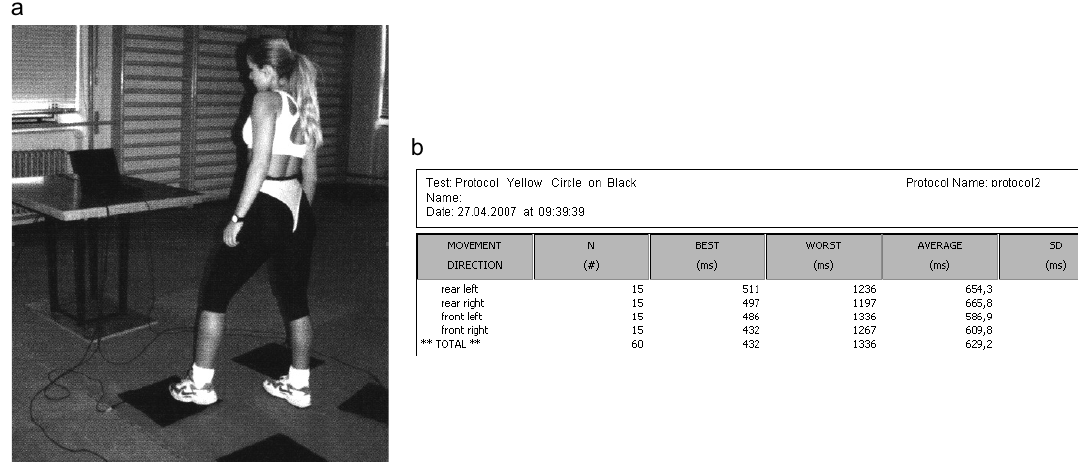
Figure 1. The Agility test (a), summary report of the test